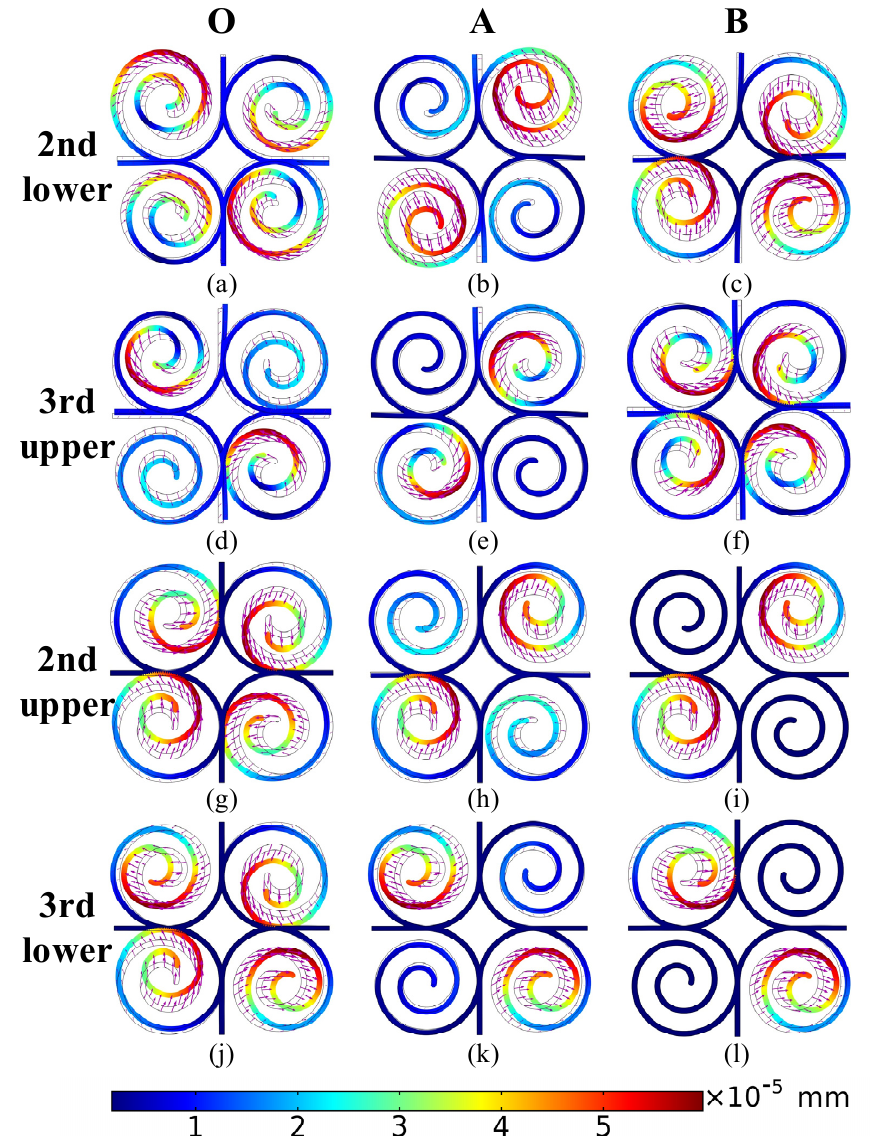
Figure 4. Mode shapes of the proposed structure: ( a – c ) represent the points (O, A, B) of the IBZ on the sixth branches the lower edge of the second bandgap; ( d – f ) represent the points (O, A, B) of the IBZ on the ninth branches the upper edge of the third bandgap; ( g – i ) represent the points (O, A, B) of the IBZ on the seventh branches the upper edge of the second bandgap; ( j – l ) represent the points (O, A, B) of the IBZ on the eighth branches the lower edge of the third bandgap; the arrows represent the magnitude and direction of the displacement of the mode.